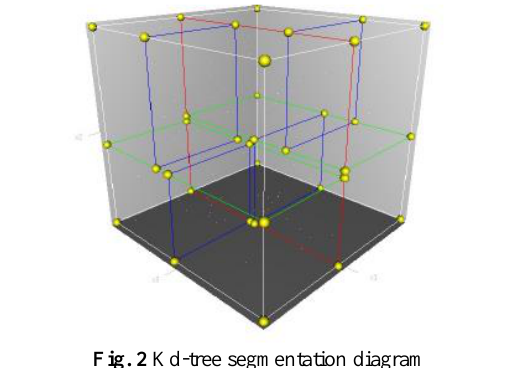
Fig. 2 Kd-tree segmentation